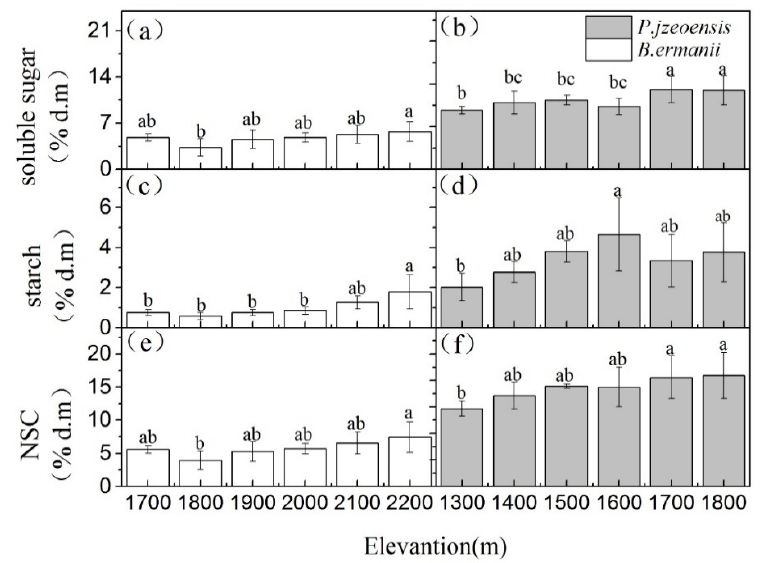
Figure 5. Variation in the concentrations of B. ermanii fine roots ( a ) soluble sugar, ( c ) starch and ( e ) NSC as well as P. jezoensis stems ( b ) soluble sugar, ( d ) starch and ( f ) NSC (mean ± SD; % of dry matter) along with elevational gradients in Changbai Mountain ( n = 5 for each elevational site). Different letters indicate significant differences ( p < 0.05) among elevations as determined by Tukey’s HSD test single-factor ANOVAs.